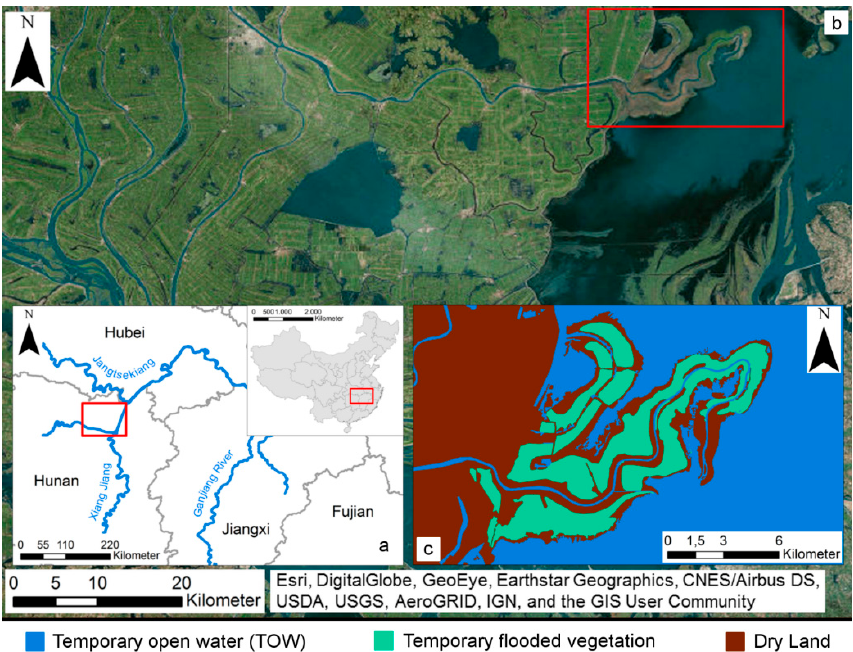
Figure 4. Overview map with the location of the study area (red rectangle) in China ( a ), study area in China ( b ). The red rectangle represents the reference mask extent ( c ), which was derived from S-2 data (June 27, 2017). Table 2. Acquisitions dates of the S-1 satellite data used for China. The scene acquired on June 28, 2017 (highlighted with blue background) was used within this study as a flood event